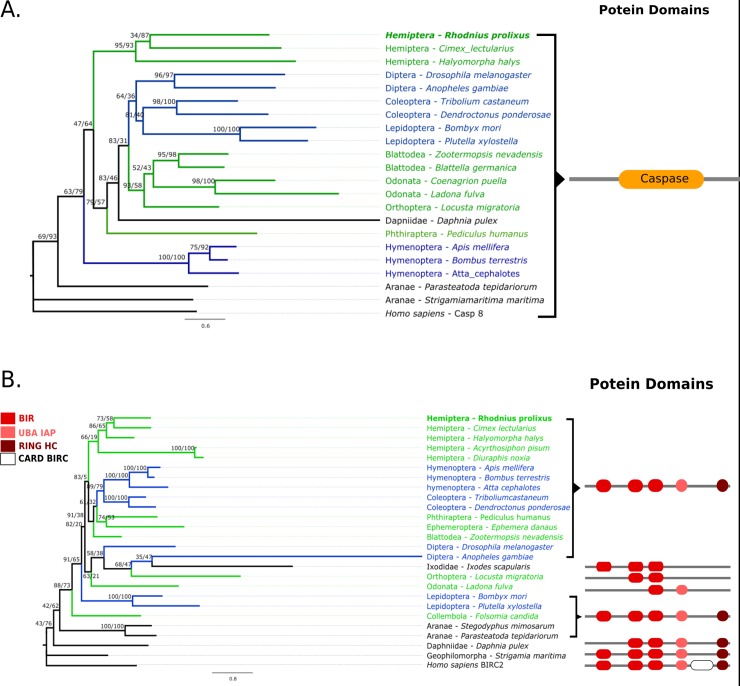
DREDD and CASPAR Maximum likelihood phylogenetic trees in selected arthropods.(A) rpDREDD forms a clade with other hemipterans but is distinct from other hemimetabolous insects (green). (B) rpCASPAR forms a clade with other paraneopteran insects except for aphids which form a distinct clade basal to most insects. The human Caspase 8 and FAF1 were used as outgroups to build the ML trees.